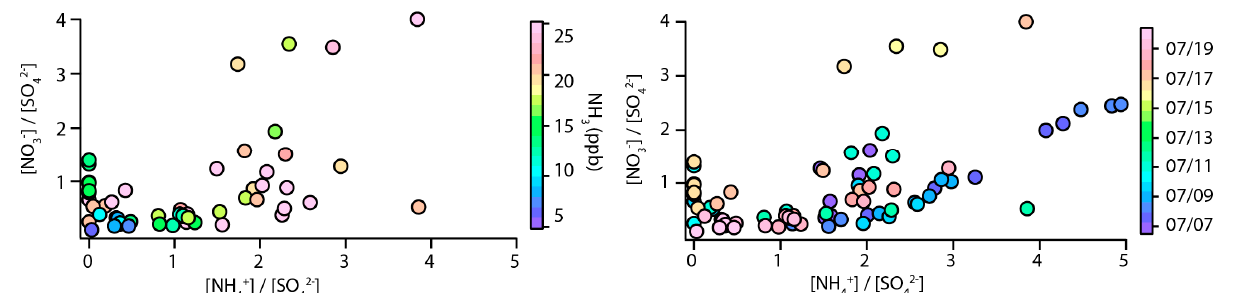
Figure 7. Ions cross-plots for the molar ratio of NH 4+ /SO 42 − vs. NO 3 − /SO 42 − .